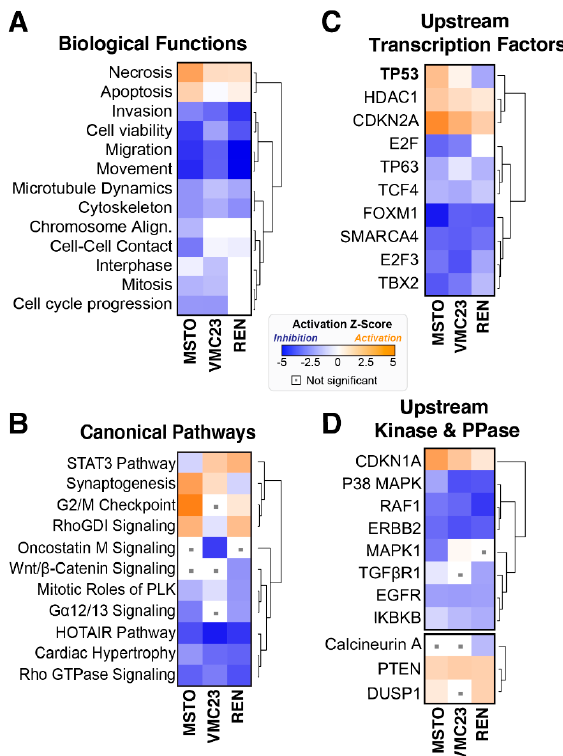
Figure 3. Comparative analysis of RNA-seq data suggests MPM cells respond differently to YB-1 knockdown. ( A – D ) Hierarchical clustering of IPA comparative analysis for indicated pathways. Variable stringent p -value (>1.3) and z-score (>0.5) cut-offs were used to limit pathways to below top 15 most significant hits. Orange (activation), blue (inhibition), white (no change), insignificance threshold < 0.05 (grey dot).